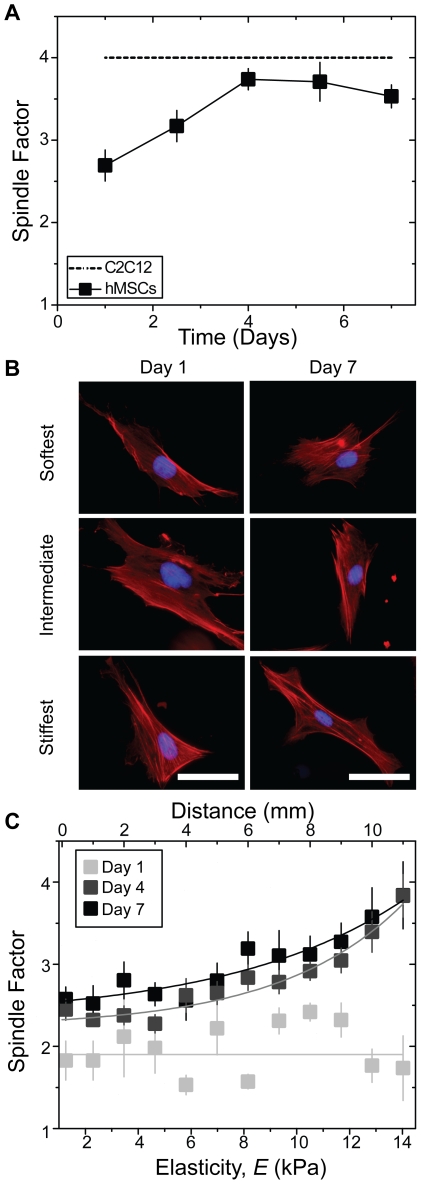
Morphological changes of MSCs as a function of time on gradient hydrogels.(a) MSCs cultured on static 11 kPa hydrogels increase their spindle factor whereas C2C12 myoblasts remain spindle-shaped throughout culture time as shown in [11]. (b) Morphological changes in cells stained with Hoescht 33342 (blue) and phalloidin (red) can be observed as a function of culture time and stiffness in MSCs cultured on gradient hydrogels. Scale bar is 12.5 µm. (c) Quantification of the spindle factor, i.e. the major divided minor axes, from images in (b) shows no relationship to stiffness at day 1, but by 4 and 7 days in culture, spindle factor increases from about 2.5 to 4 as a function of gradient stiffness.